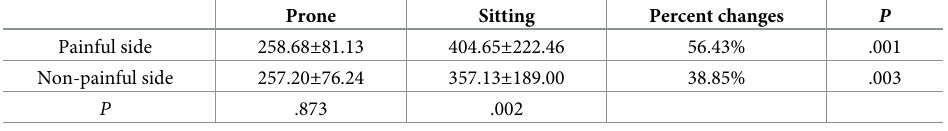
Table 2. An independent t test of the lumbar erector spinae muscles stiffness between painful and non-painful sides in human participants with CLBP. Prone